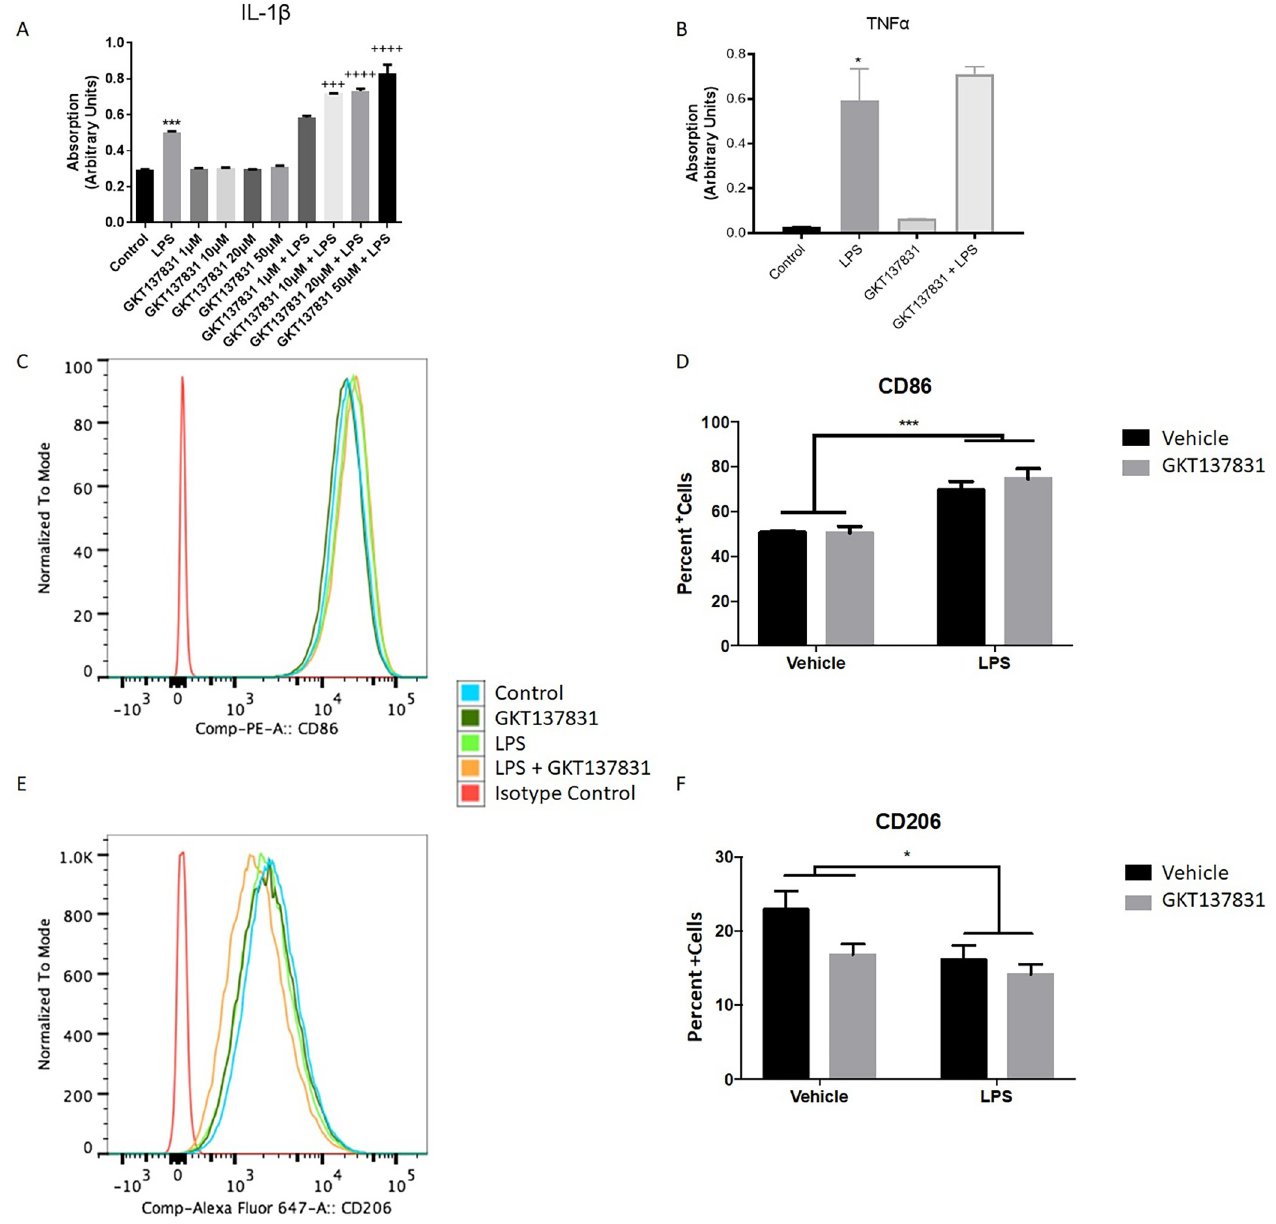
Fig 6. GKT137831 treatment has limited effects on microglial related inflammatory responses. BV2 microglia were stimulated with LPS and treated 1 hour after with the NOX inhibitor GKT137831 at 0.5 μ M, 1 μ M, 5 μ M, 10 μ M. Media was collected 24 hours after stimulation. IL-1 β ELISA assay shows no response by microglia to GKT137831 along, but in conjunction with LPS there was a significant dose dependent increase in release (A). GKT137831 showed no effect on TNF- α release, with or without LPS stimulation (B). When BV2 microglia were stimulated with LPS, a significant increase of the pro-inflammatory marker CD86 + cell population (C, D) and reduction in the CD206+ cell population (E, F) was observed GKT137831 did not prevent or induce any polarization changes by itself or after LPS stimulation. N = 3. � p < 0.05, �� p < 0.01, ��� p < 0.001 using two-way ANOVA. Bars represent mean +/-